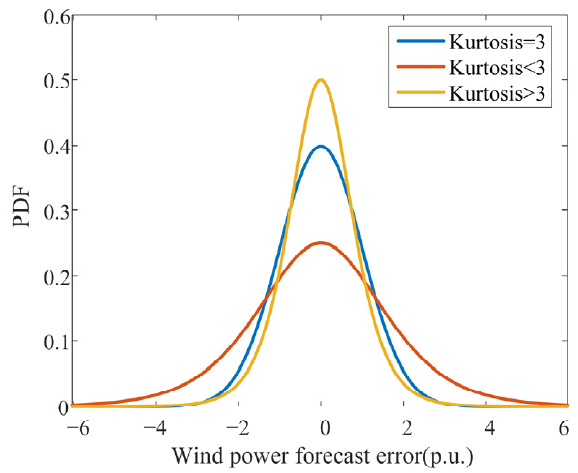
Figure 2. PDF curves of WPFE and corresponding kurtosis.